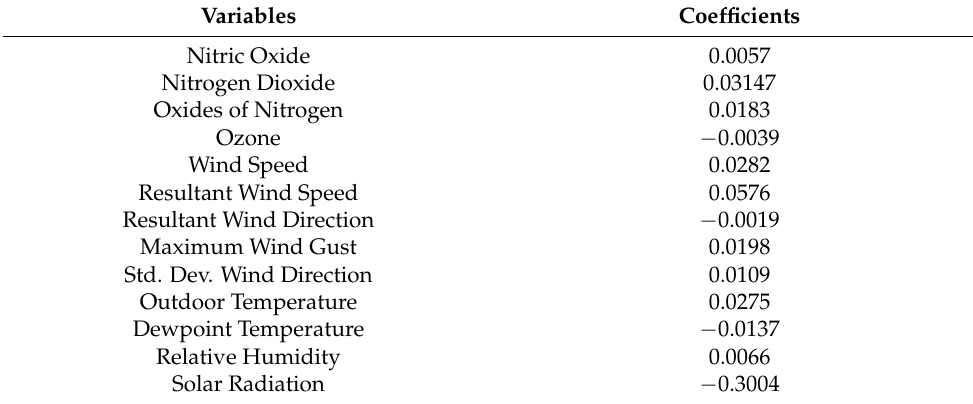
Table 3. Coefficients of lasso model.